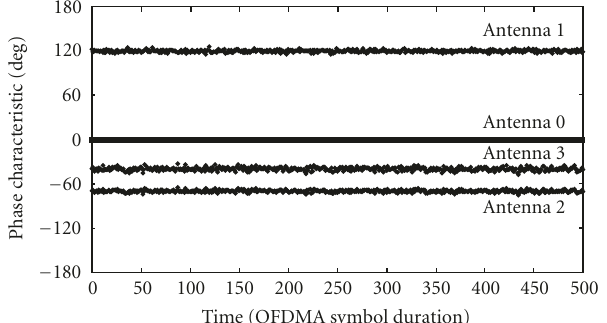
Figure 12: Phase characteristics obtained by experiment before calibration.